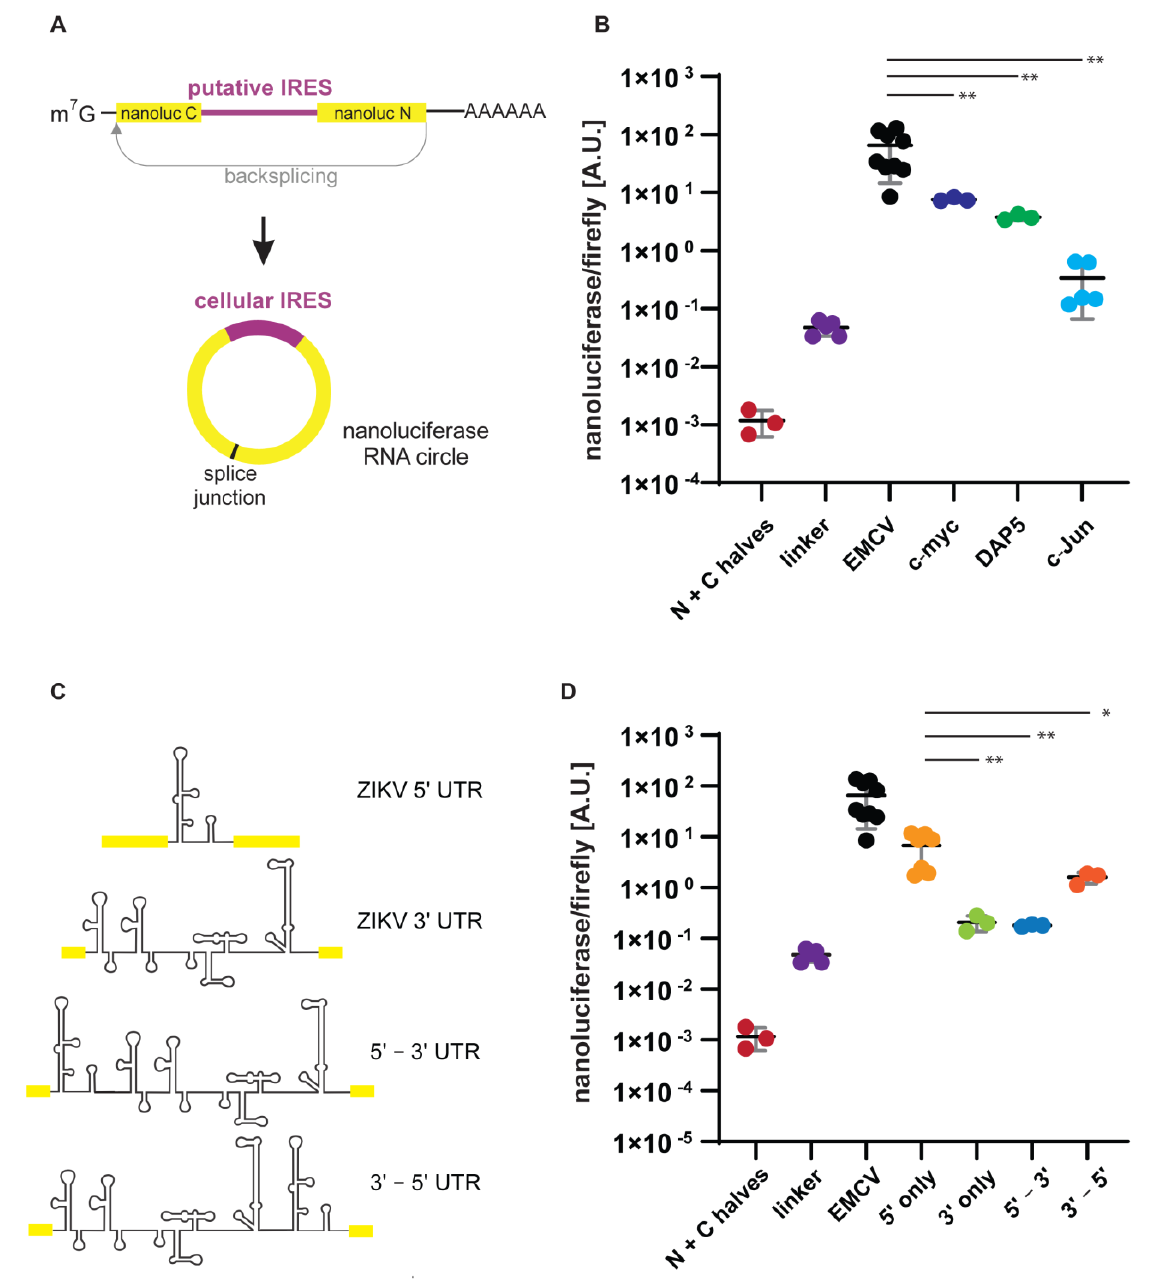
Figure 2. The relative activity of cellular IRESs can be quantified with a split NanoLuc reporter. ( A ) Putative cellular IRES sequences for c-Myc, DAP5 and c-Jun were cloned and inserted into the SbfI and EcoRV sites of the split NanoLuc reporter, generating a linear and a circular RNA. ( B ) Relative activity of cellular IRESs is measured by NanoLuc over firefly luciferase ratio. All experiments were performed at least in triplicate. Error bars represent the standard deviation. ( C ) ZIKV 5 ′ and 3 ′ UTRs RNA secondary structures and secondary structures in a combination of 5 ′− 3 ′ , 3 ′− 5 ′ UTRs ( D ) NanoLuc over firefly luciferase ratio from ZIKV 5ʹ and 3ʹ UTRs alone, or in a combination of 5 ′ -3 ′ , 3 ′ -5 ′ UTRs. Data for co-expression of N − and C − terminal fragments (N + C halves), the empty plasmid with a short 9 bp unstructured linker, and the EMCV IRES are identical to the data from Figure 1B, however, were plotted again for direct comparison. All experiments were performed at least in triplicate. Error bars represent the standard deviation. Significances were calculated using an unpaired t test with Welch’s correction with p ≤ 0.05 = *, p ≤ 0.01 = ** .